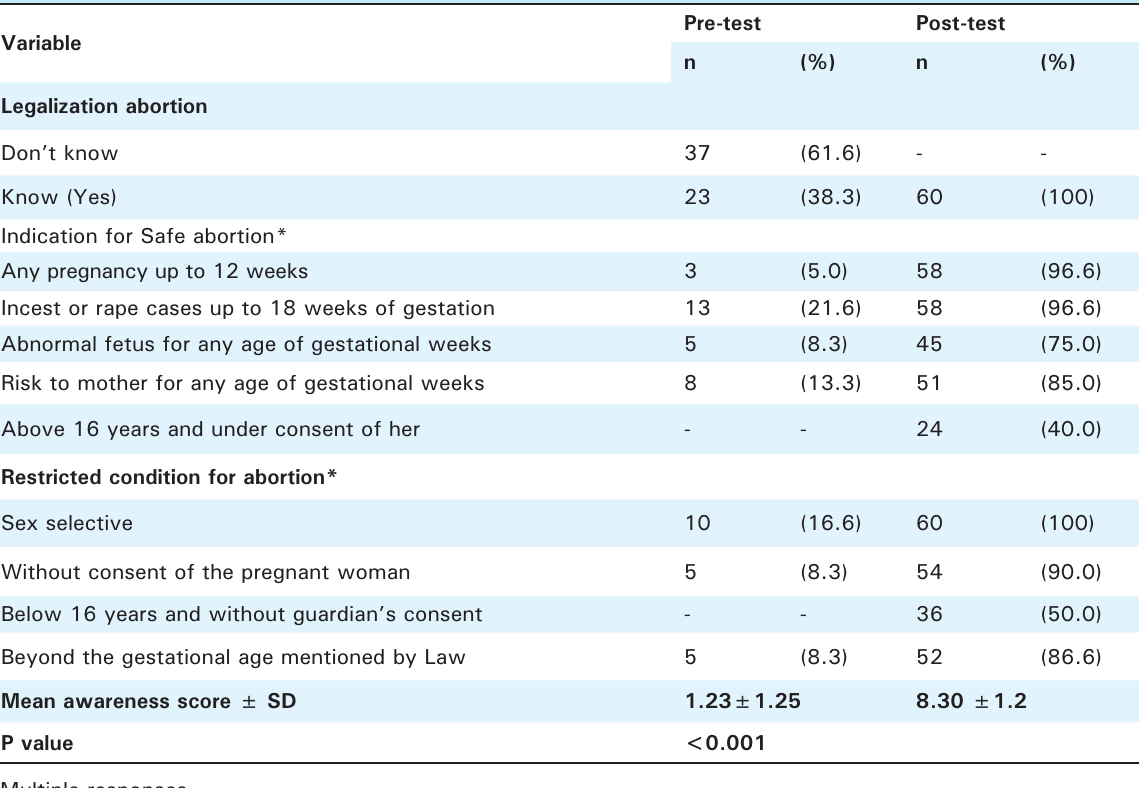
Table 4. Respondents’ Awareness about Abortion Law of Nepal